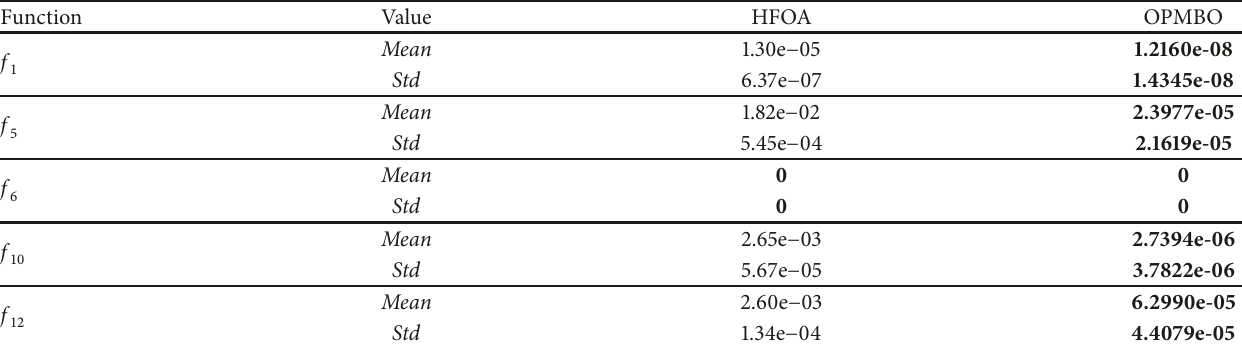
Table 7: The comparison results of OPMBO with HFOA on 30 dimensions with a population size of 50. Function